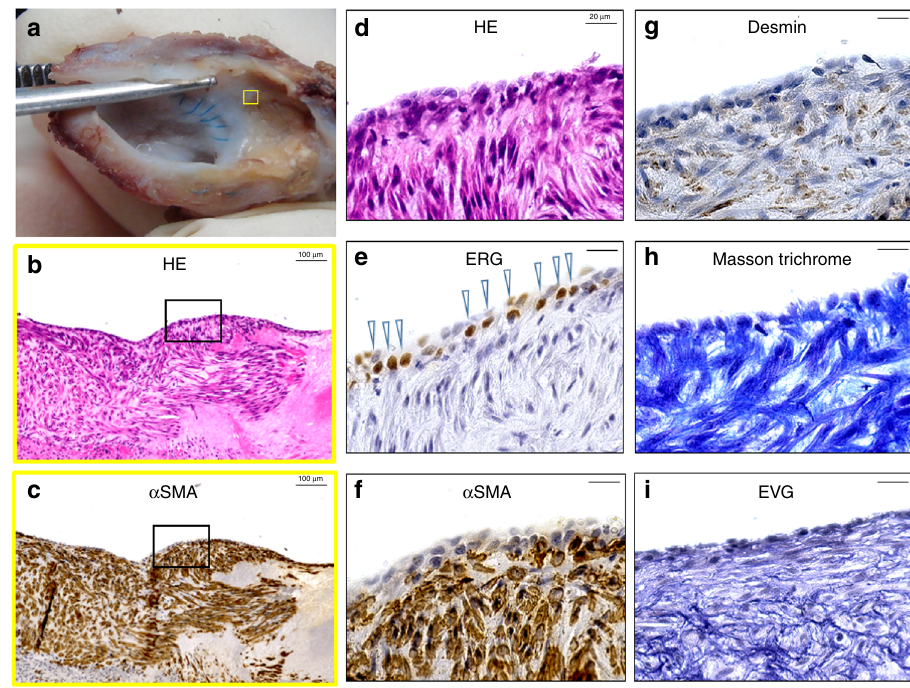
Fig. 5 The histological analysis of the HOBPT at 1 month after transplantation in OIDPs. The luminal surface of the HOBPT was whitish, smooth and contiguous from the surface of the recipient ’ s common carotid artery without thrombus a . Microscopically, the luminal surface was lined with a monolayer of fl at cells b , d expressing ERG (an endothelial cell marker) e . Host-derived spindle-shaped cells migrated into the HOBPT wall from the upper, lower, and lateral margins b , and the cells expressed the smooth muscle cell markers alpha-SMA c , f and desmin g . Elastica van Gieson staining showed “ neomedia ” containing elastic fi bers beneath the luminal surface i in the collagenous extracellular matrix, which was stained blue by Masson – trichrome staining h . Scale bar: 100 µ m in b , c , 20 µ m in d – i . HOBPT: human original 3D bioprinted tube, OIDP: operational immunode fi cient